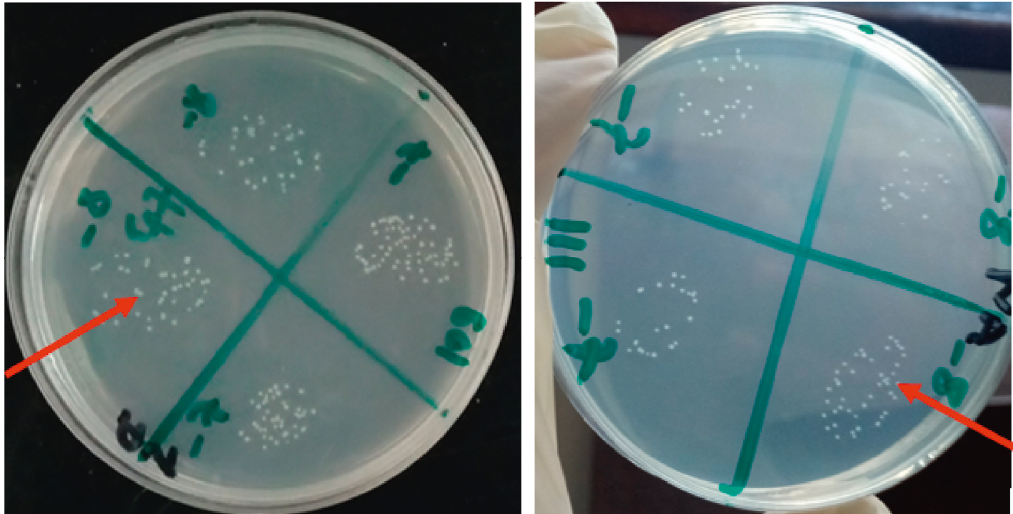
Figure 1: Countable colonies on nutrient agar media as pointed by the red